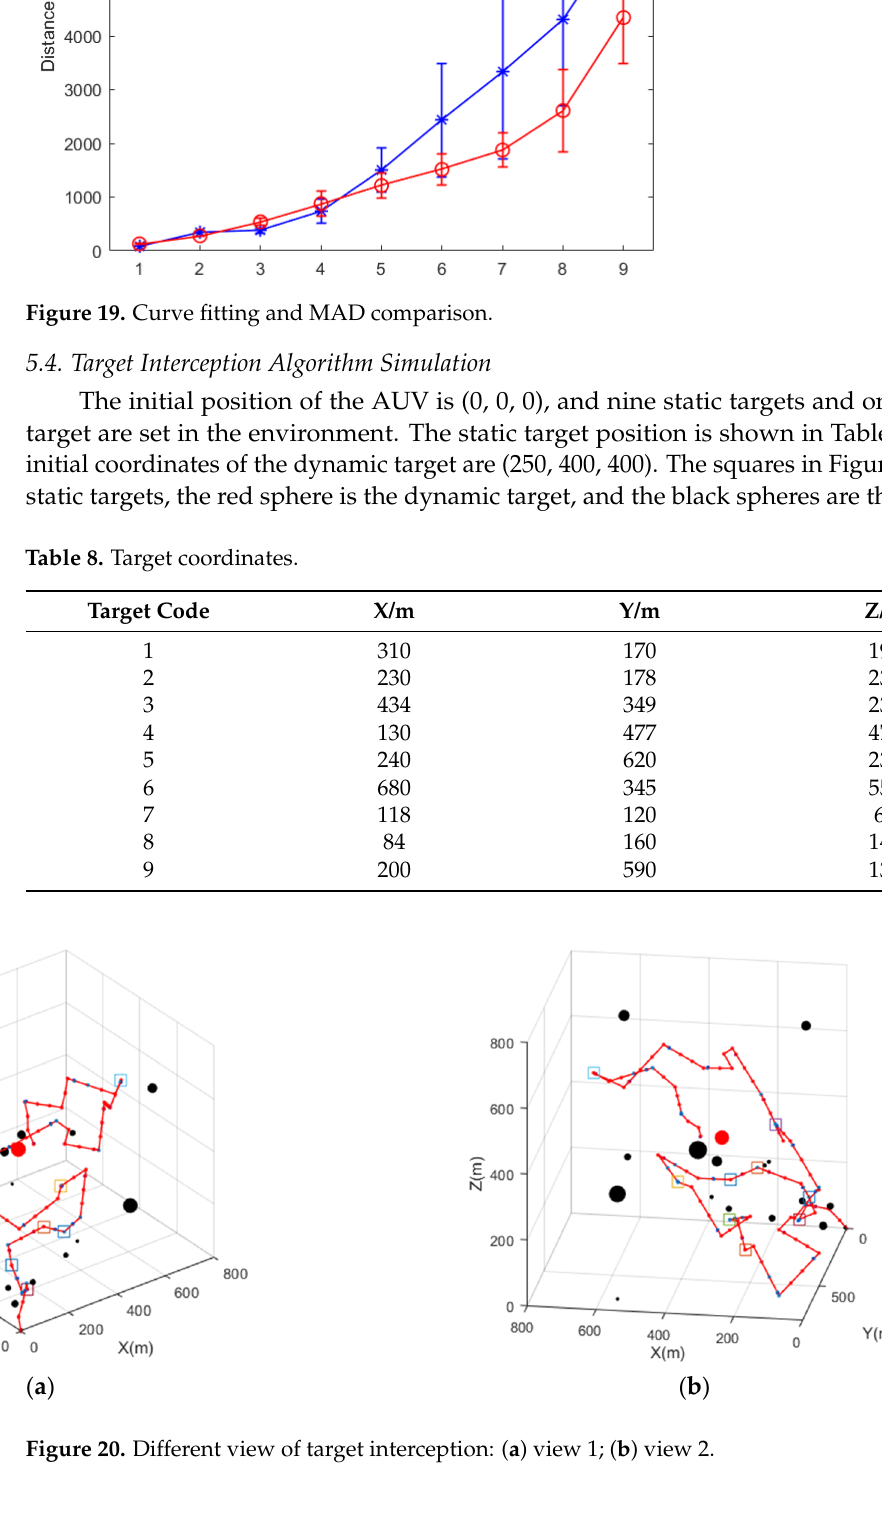
Figure 20. Different view of target interception: ( a ) view 1; ( b ) view 2.